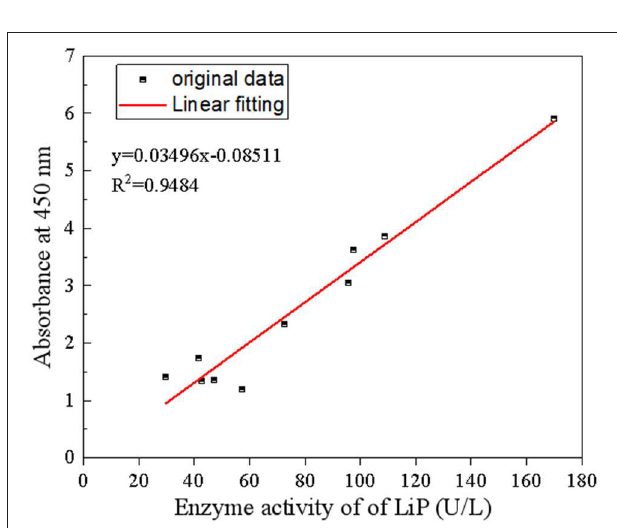
FIGURE 5 | Relationship between LiP activity and the liquefaction effect of mixed white rot fungi.